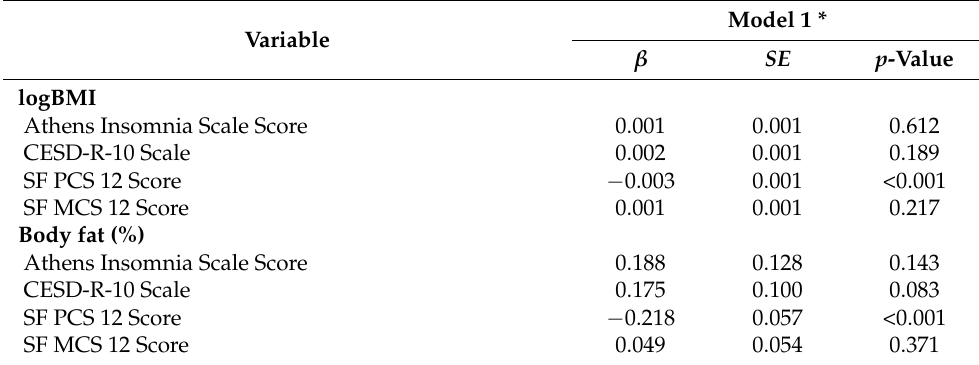
Table 3. Multivariate linear regression analyses on the relation between lifestyle characteristics and BMI and body fat baseline